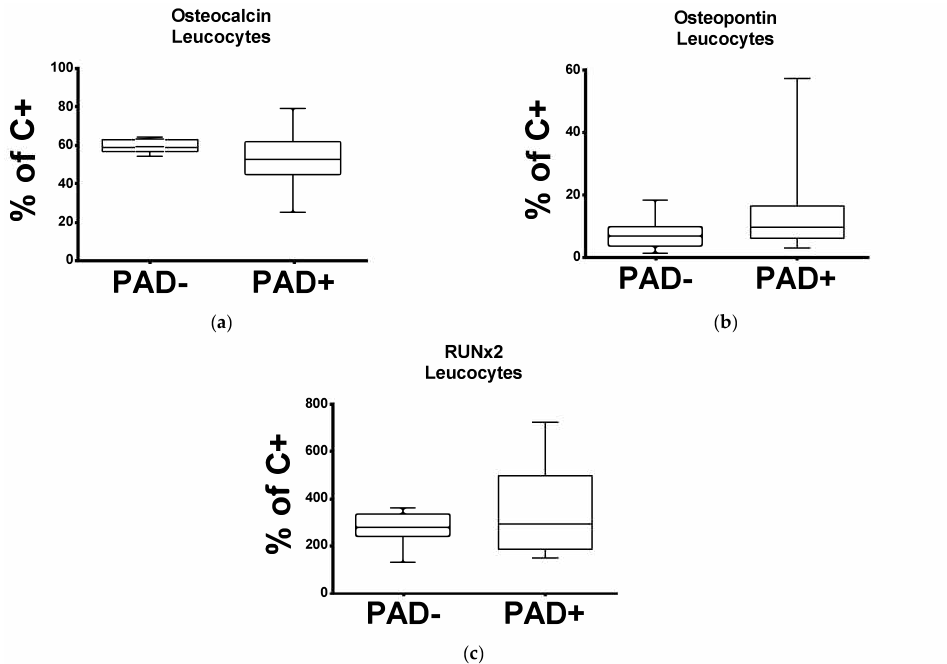
Figure 1. Expression of osteocalcin (OC) ( a ), osteopontin (OPN) ( b ) and RUNX2 ( c ) in leucocytes obtained from the PAD − and PAD+